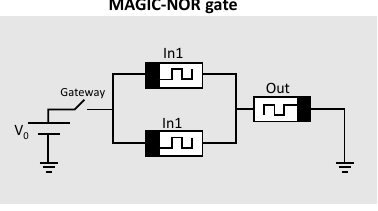
Figure 4. Structure of MAGIC NOR